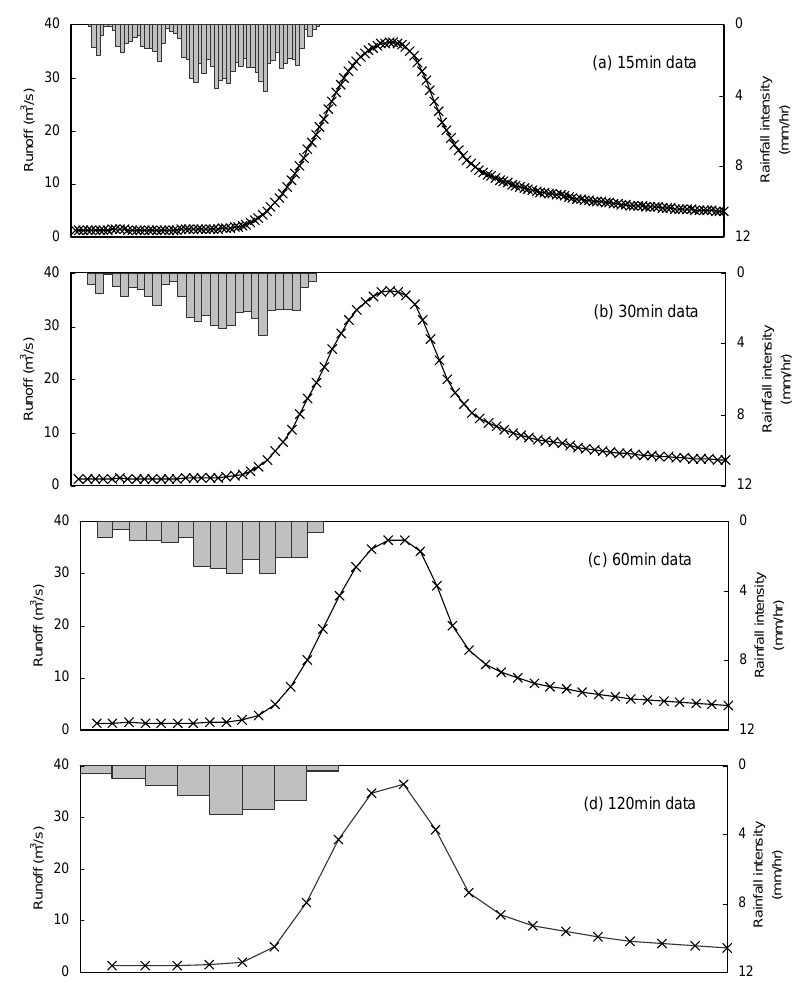
Fig. 1. Observed rainfall–runoff data with different sampling intervals of (a) 15min, (b) 30min, (c) 60min and (d) 120min. a sampling data function where the value of the